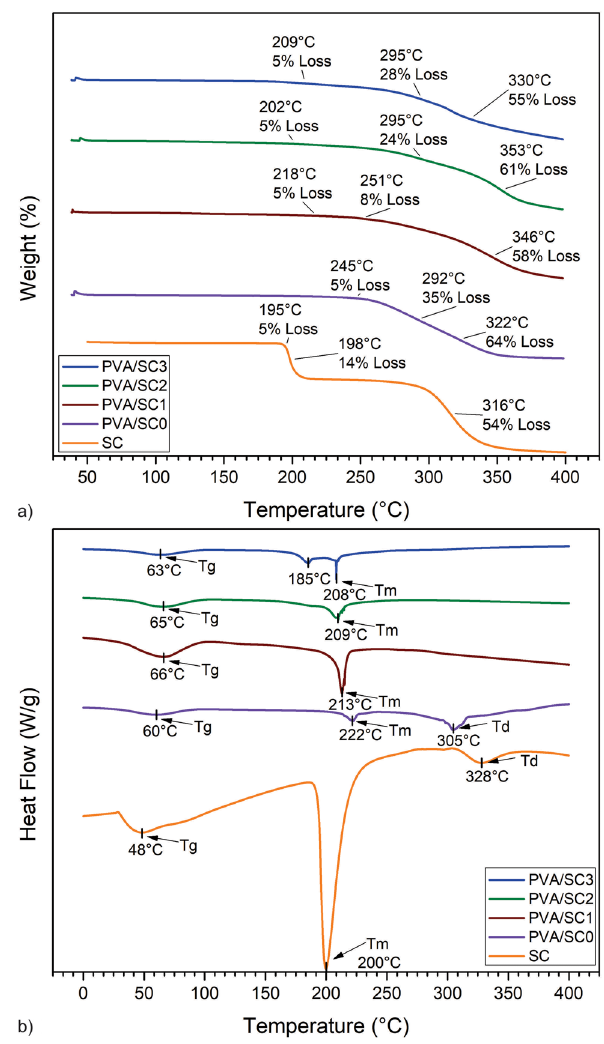
Figure 4: Thermal analysis of PVA/SC fi bers. ( a ) TGA; ( b )